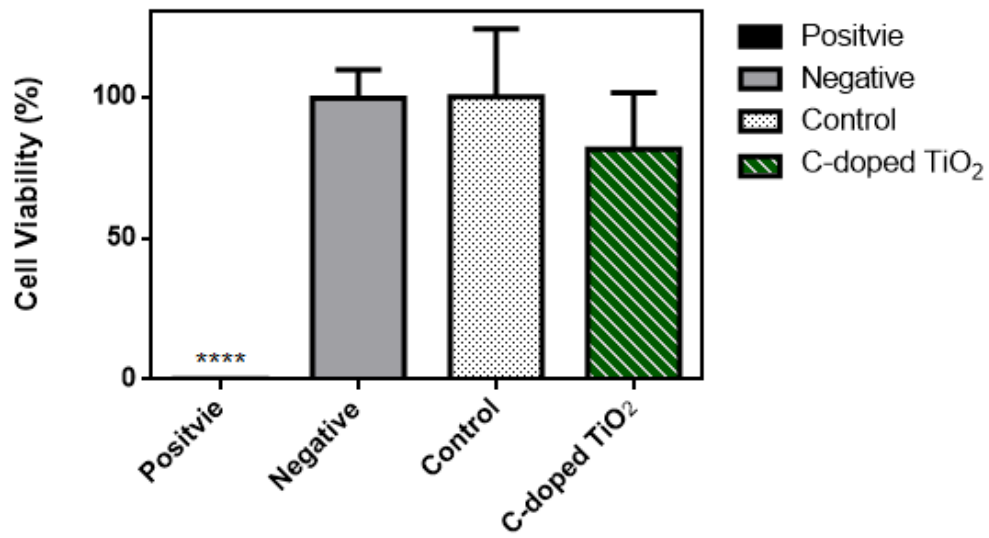
Figure 5. WST-1 test for the biocompatibility of C-doped TiO 2 (one-way ANOVA, mean ± SD, n = 5, ****: p <